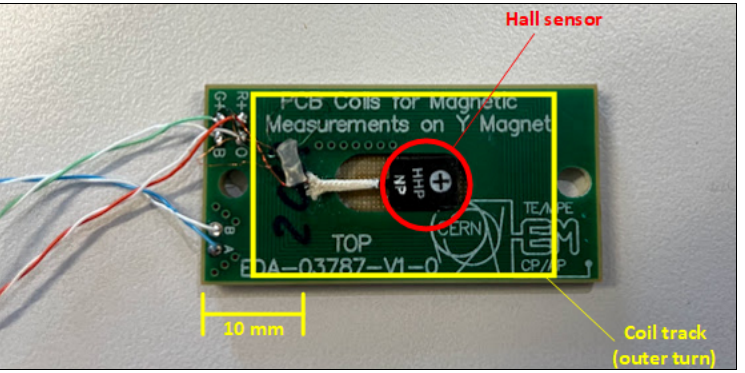
Figure 2. Layout of the measurement system.